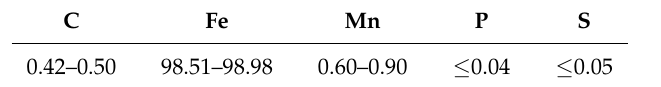
Table 1. Chemical composition of AISI-1045 medium carbon steel (in wt.%).